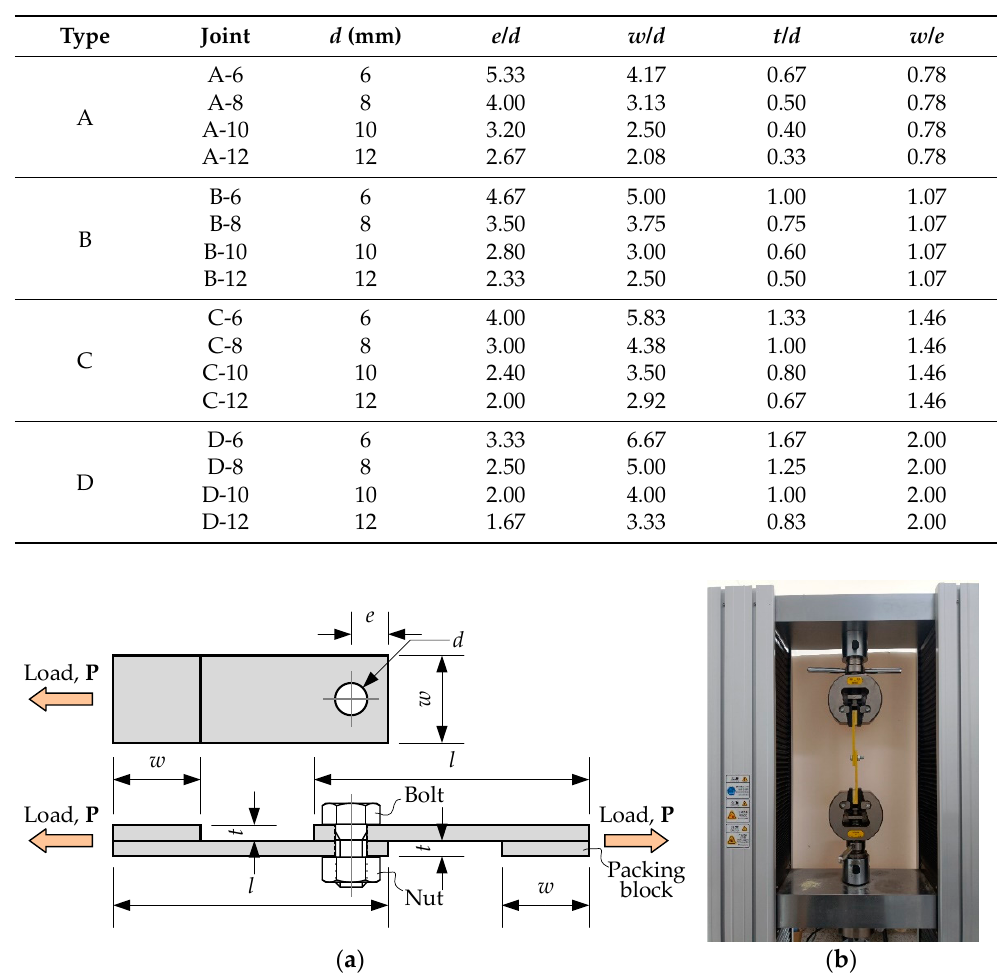
Table 3. Configuration of the test samples.